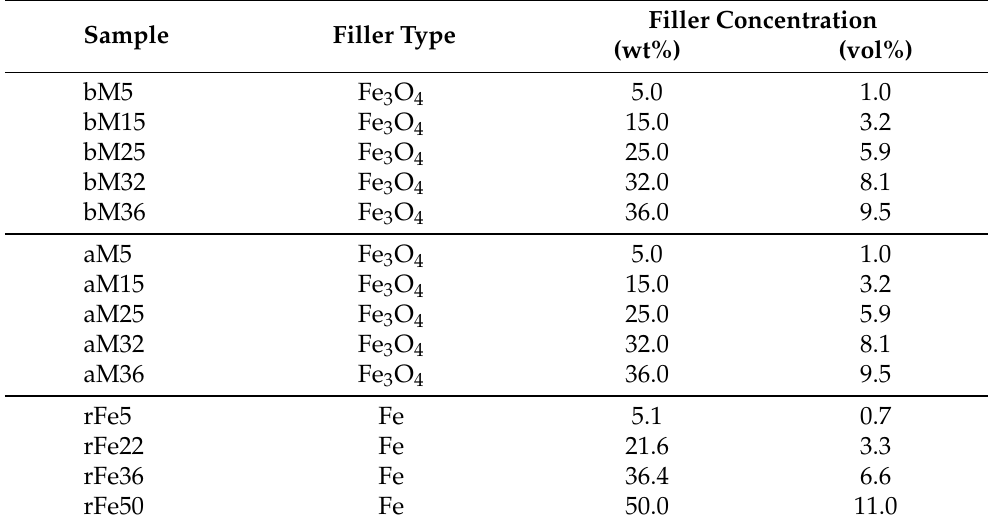
Table 1. The type and concentration of the filler materials in the fabricated